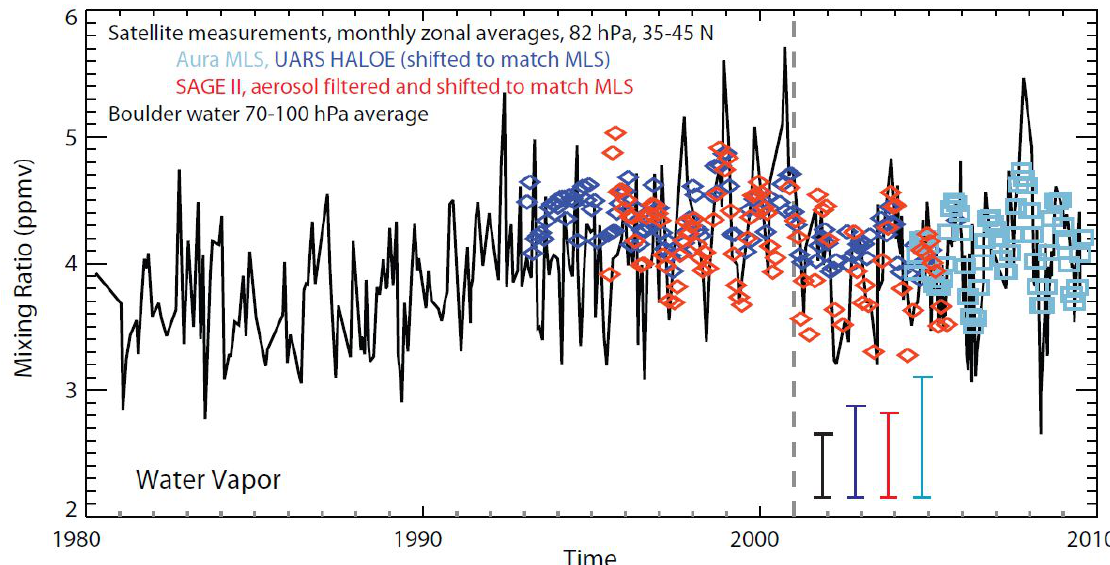
Figure 5. Observed changes in stratospheric water vapor. Time series of stratospheric water vapor mixing ratio (ppmv) averaged from 70 to 100 hPa near Boulder Colorado (40°N, 105.25°W) from a balloon-borne frost point hygrometer covering the period 1981 through 2009; satellite measurements are monthly averages, balloon data plotted are from individual flights. Also plotted are zonally averaged satellite measurements in the 35°N–45°N latitude range at 82 hPa from the Aura MLS (turquoise squares), UARS HALOE (blue diamonds), and SAGE II instruments (red diamonds). (Figure 4-2 in Chapter 4 of [2]; see also